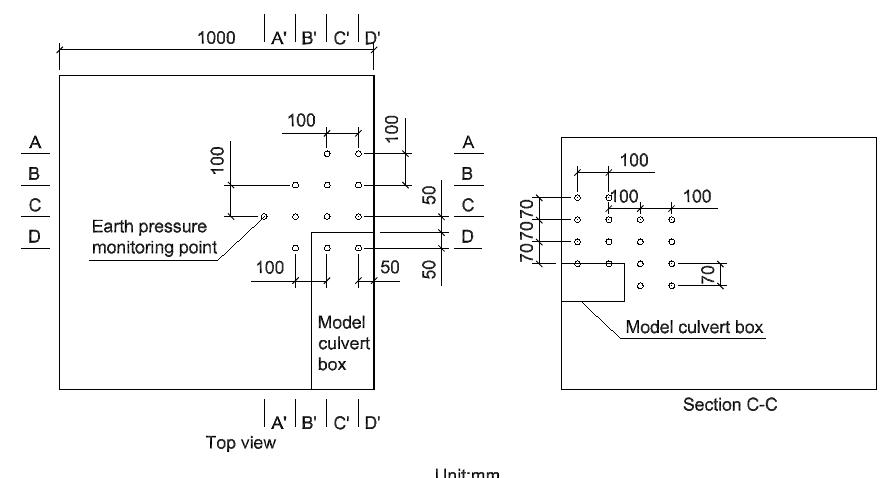
Figure 6. The layout diagram of the earth pressure monitoring point without a pipe roof.